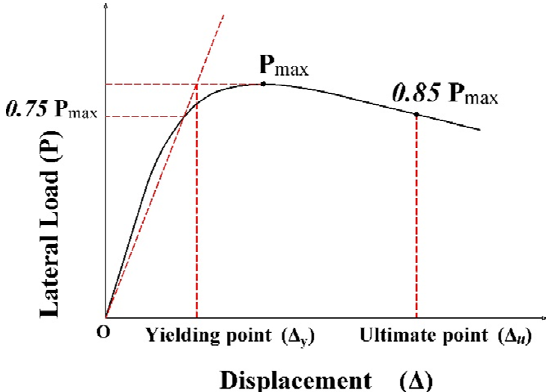
Figure 8. Define yield and ultimate displacement.